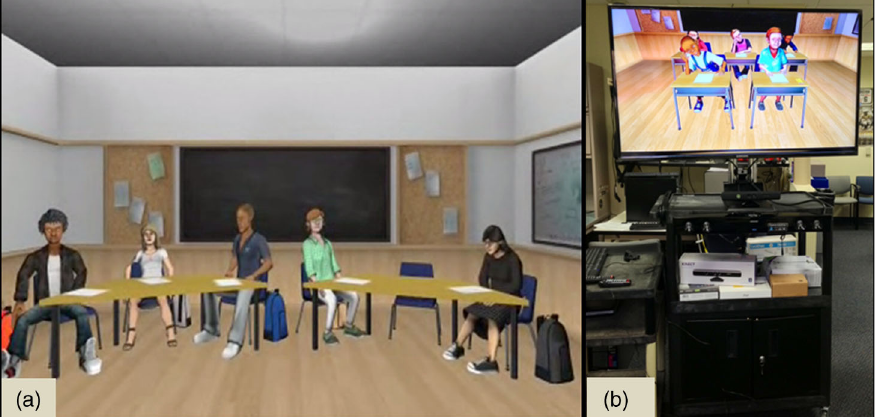
FIG. 1. The TeachLivE Simulator. (a) The high school simulator classroom and avatars. (b) The participants ’ view (with the middle school classroom shown on screen). Participants stood in front of the television screen, and their motions were tracked by Kinect and mimicked in the provided